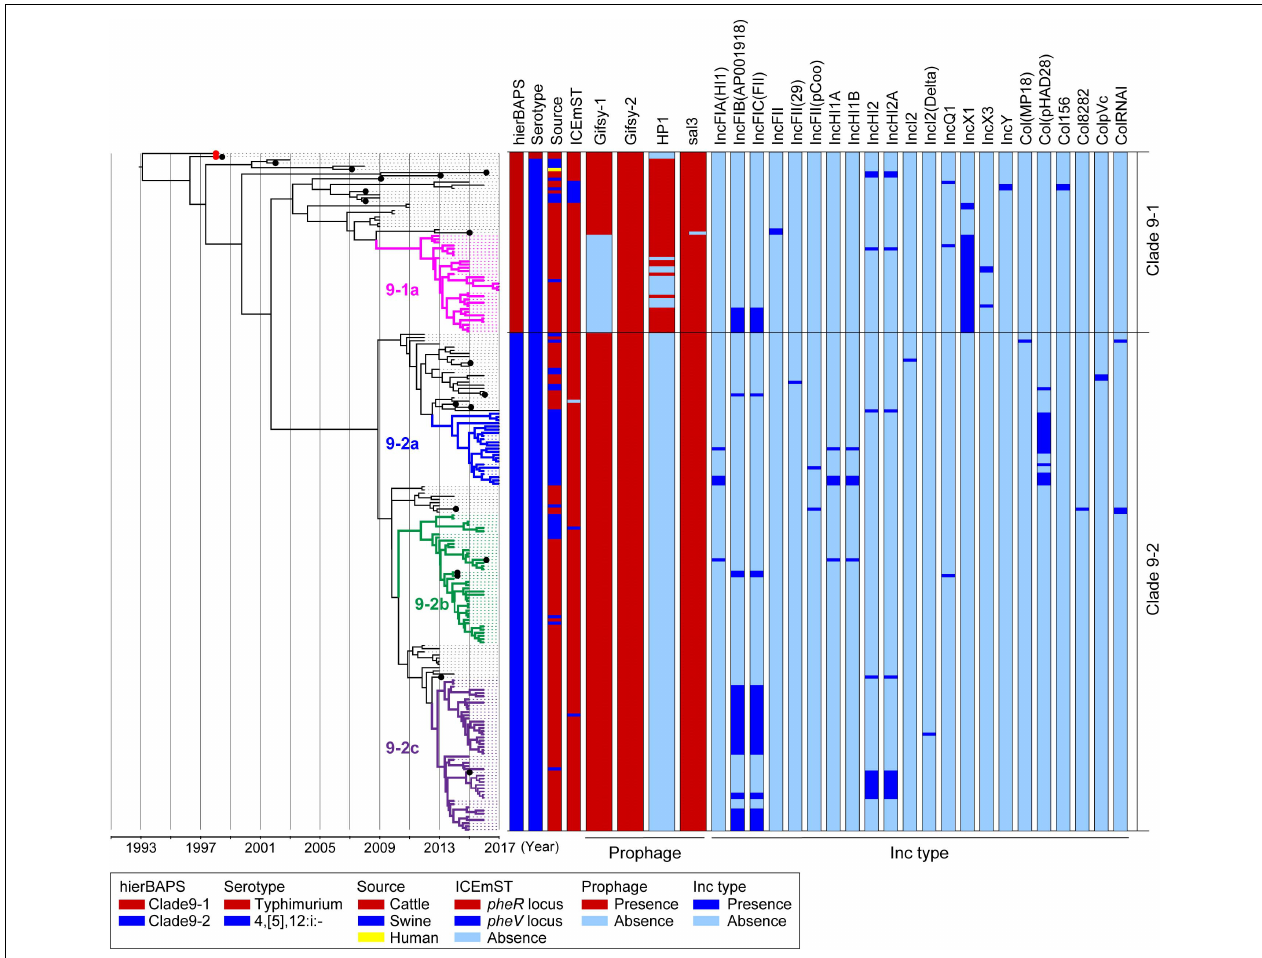
FIGURE 1 | Time-scaled phylogenetic analysis of Salmonella Typhimurium and Salmonella 4,[5],12:i:- ST34/clade 9 strains isolated in Japan between 1998 and 2017. A phylogenetic tree was reconstructed using BEAST version 1.8.2 based on 911 concatenated SNPs in the core genomic sequences of 214 wild-type strains isolated in Japan; hierBAPS cluster, serotype, country, source of isolation, and prevalence of MGEs are indicated on the right. Salmonella 4,[5],12:i:- ST34/clade 9 strain L-3837 (accession number AP023289) was used as a reference genome. Detailed information for each strain is described in Supplementary Table 2 . The red dots represent the Salmonella Typhimurium strains L-4126 and L-4127, which were isolated in 1998. The colored nodes and branches represent strains belonging to distinctive subclades: pink, 9–1a; blue, 9–2a; green, 9–2b; and purple, 9–2c. The x -axis indicates the time of emergence for each branch. The black dots represent the strains for which the complete sequences were